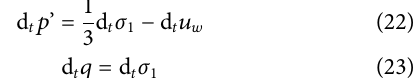
FIGURE 4 | Stress-strain relationship and model prediction results of sandy soil under different initial relative